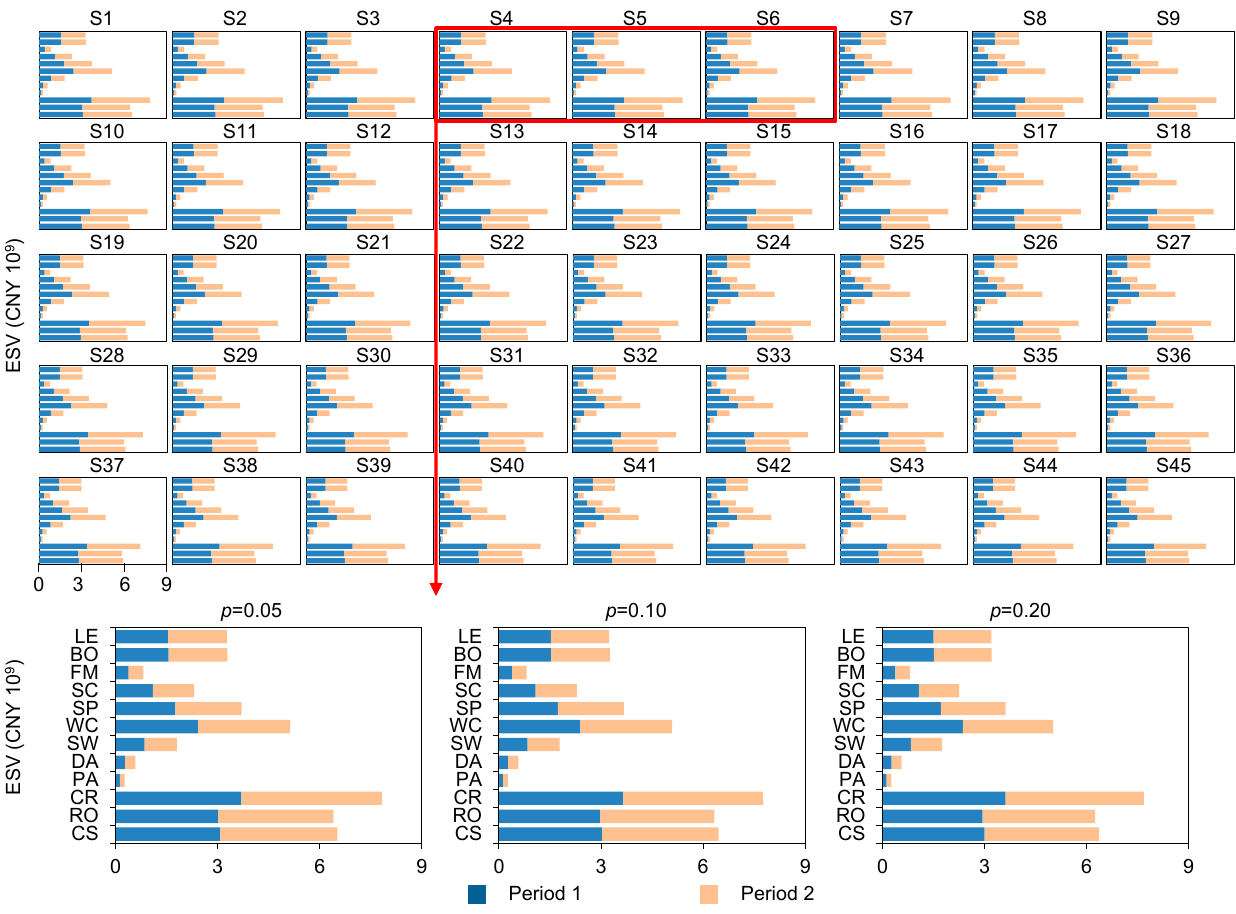
Figure 5. The ESV of ecosystem under di ff erent scenarios.